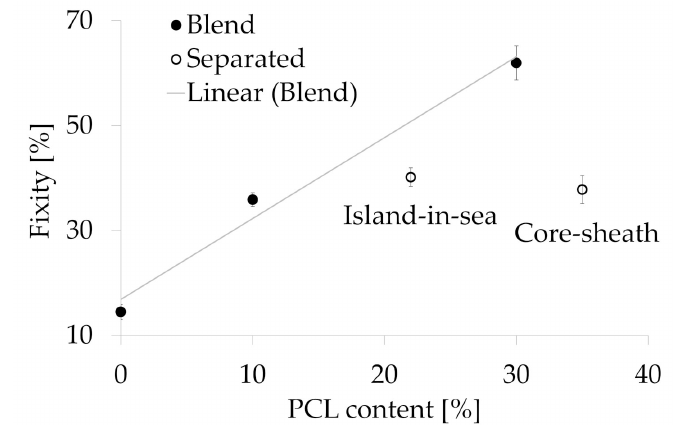
Figure 9. Experimentally obtained fixity values in dependence of PCL content, which was measured for blend samples (closed circles) and calculated from DSC measurements for island-in-sea and core-sheath samples (open